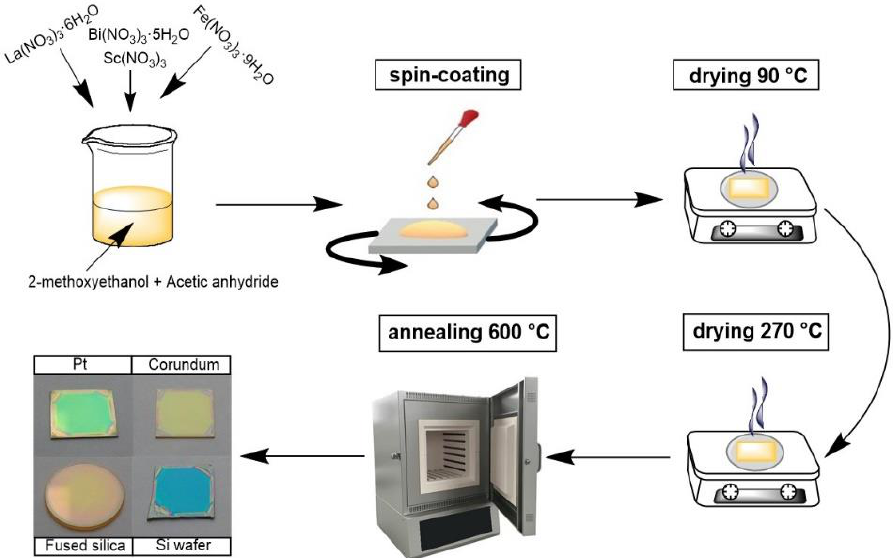
Figure 1. Schematic representation of the synthesis of BLFSO thin films and optical photographs of the films deposited on Pt/TiO 2 /SiO 2 /Si, corundum, silicon and fused silica substrates.